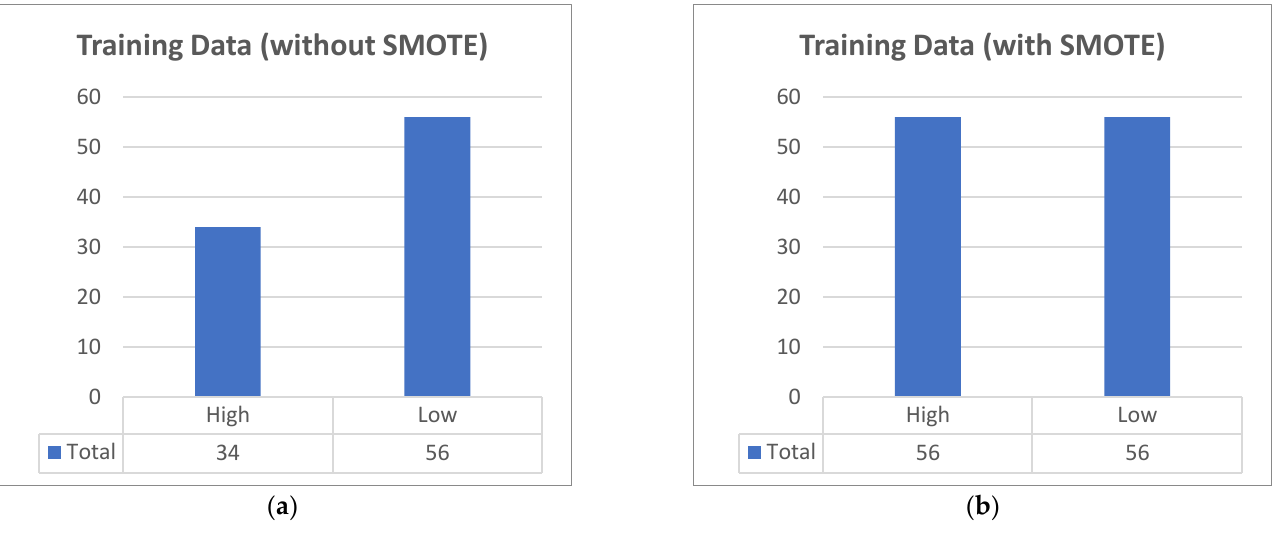
Figure 2. The dataset collected was unbalanced. ( a ) Originally, there were 90 rows; there were more low-risk pregnancies than high-risk. ( b ) Using SMOTE, both classifications are now equally 56 rows, totaling 112 rows.